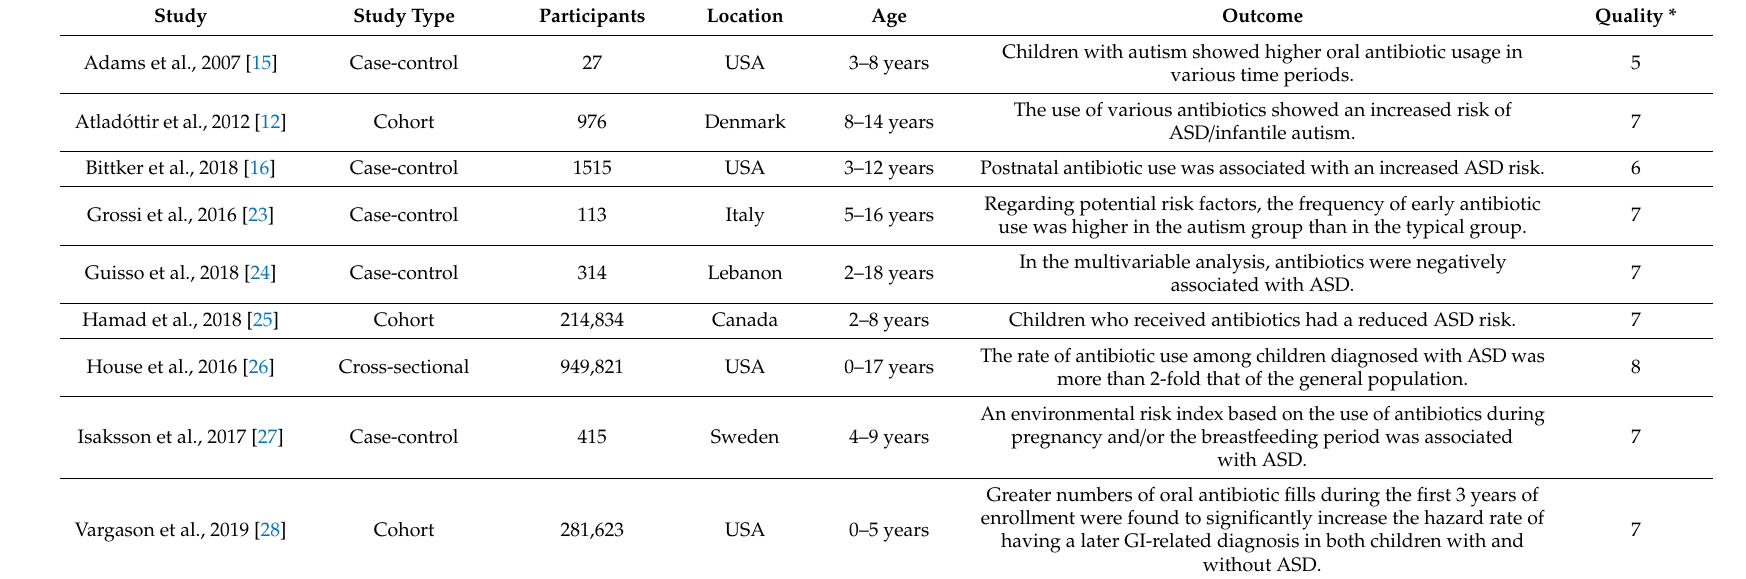
Table 1. Characteristics of the 9 included studies on the association between antibiotic exposure and autism spectrum disorder (ASD) in